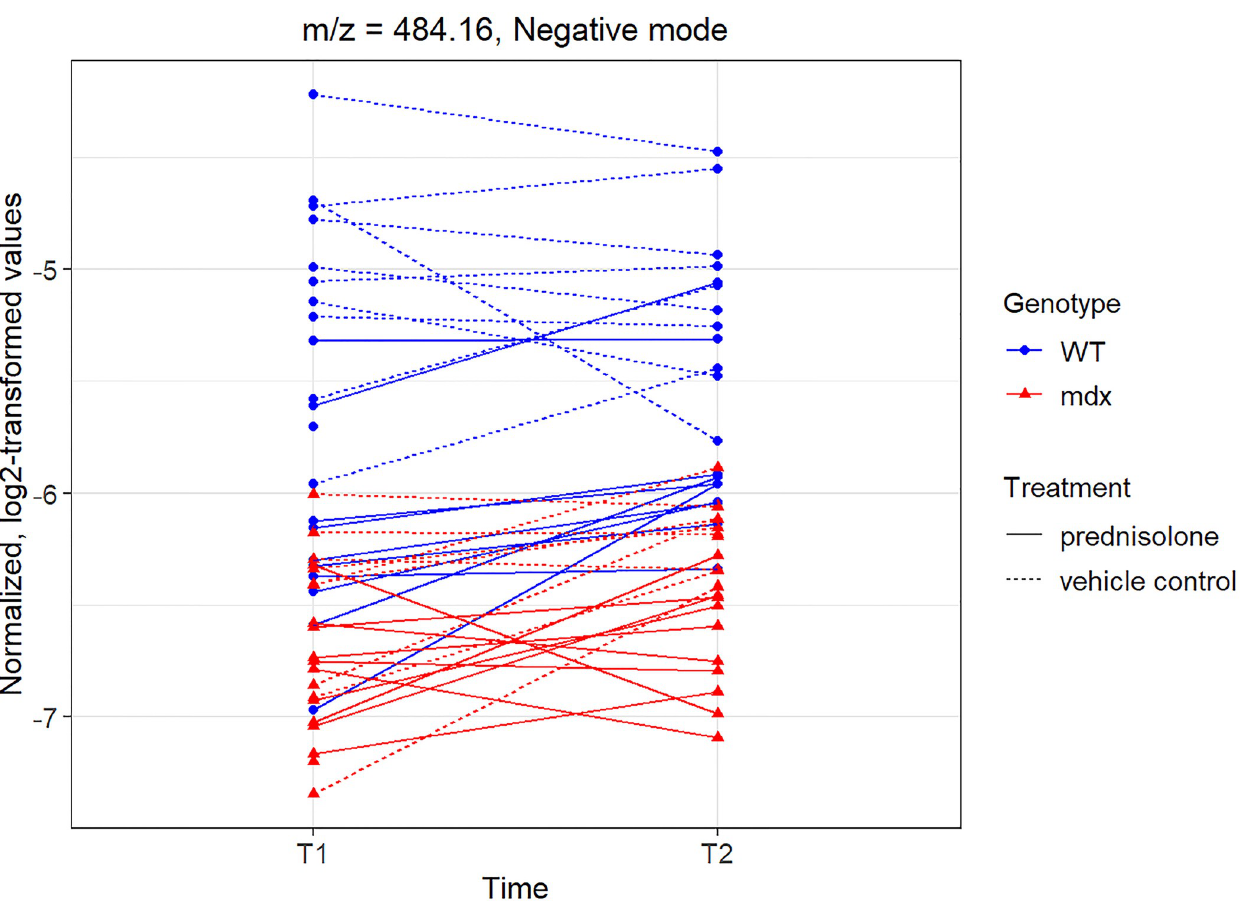
Fig 6. Normalized, log2-transformed intensity values at times T1-T2 for peak with m/z = 484.16 in negative mode.